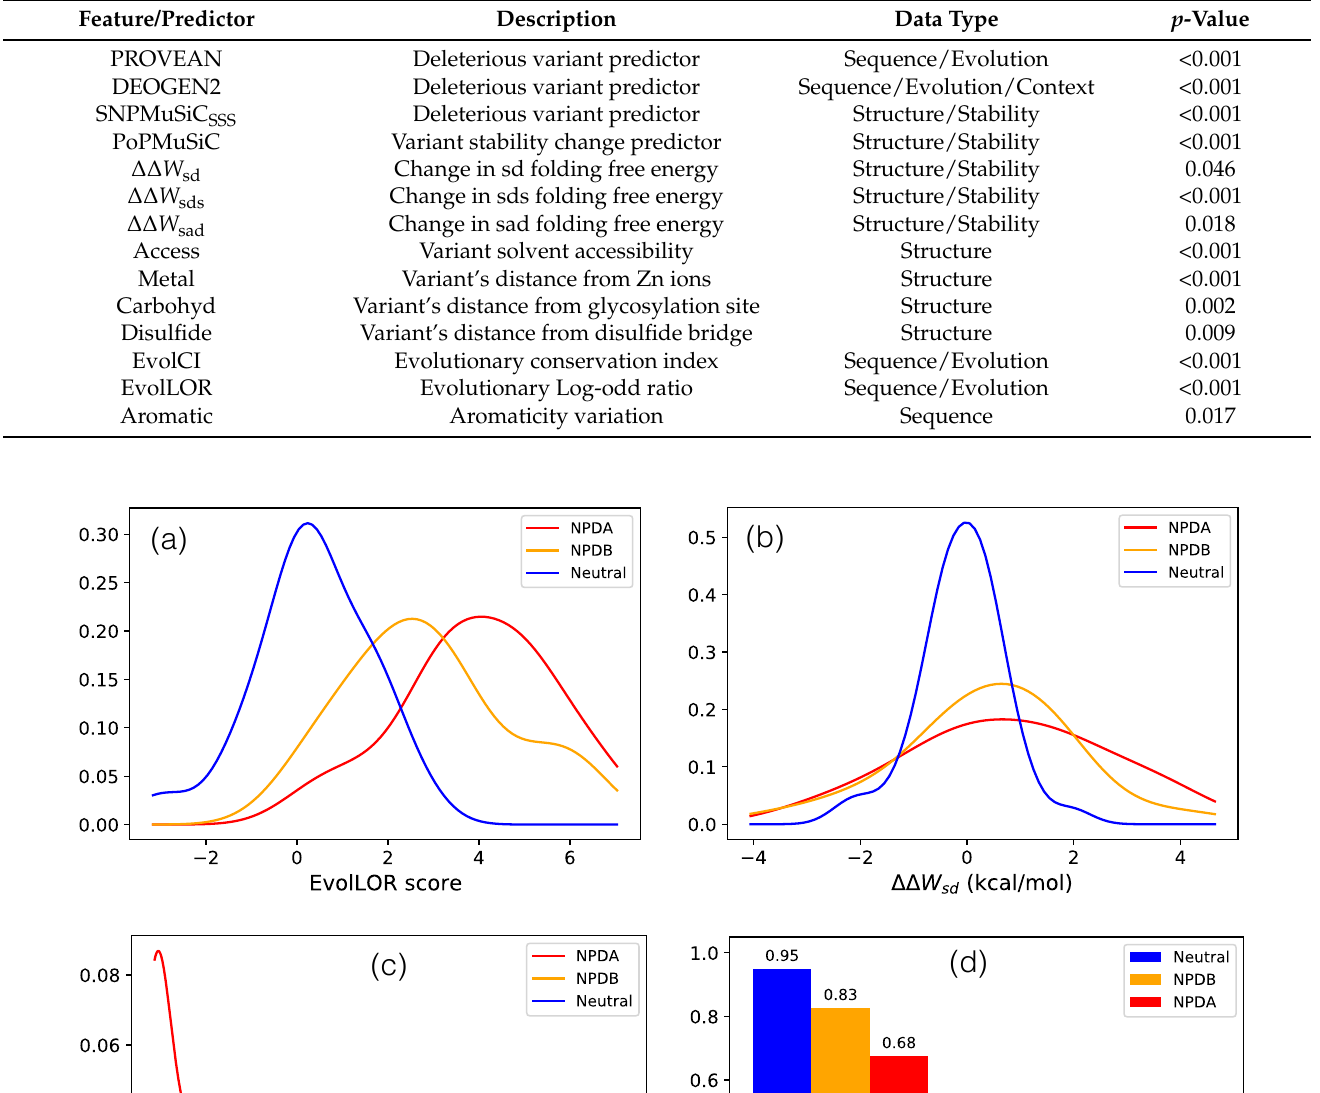
Table 1. List of generic predictors and features that can statistically significantly distinguish neutral, NPDA-causing and NPDB-causing variants. The full list of predictors and features that have been considered are given in Supplementary Table S2.